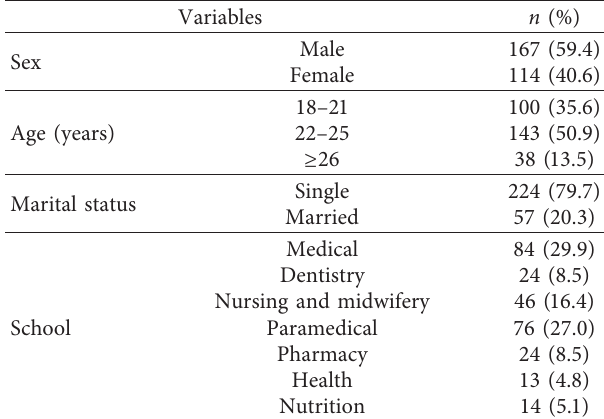
Table 1: Demographic characteristics of students ( n � 281).